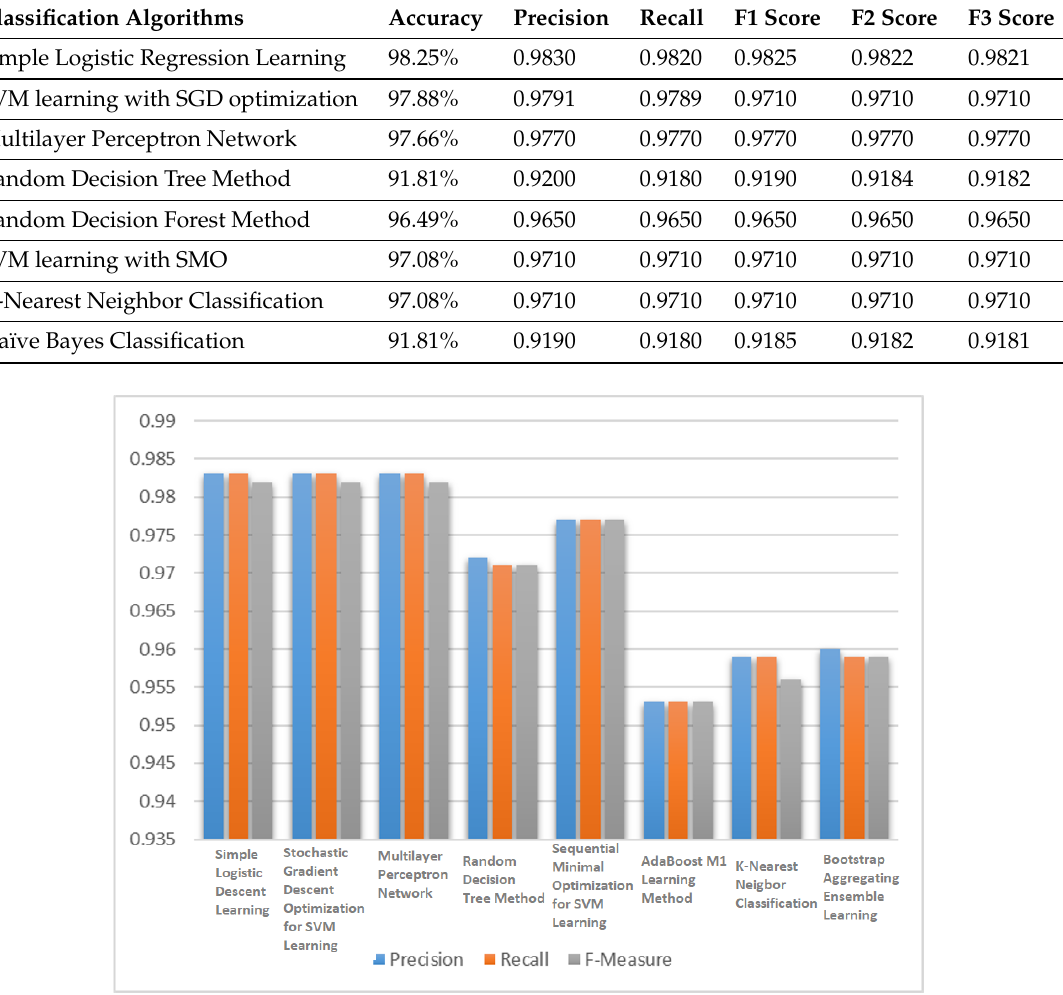
Figure 3. F3 score of the classification algorithms for